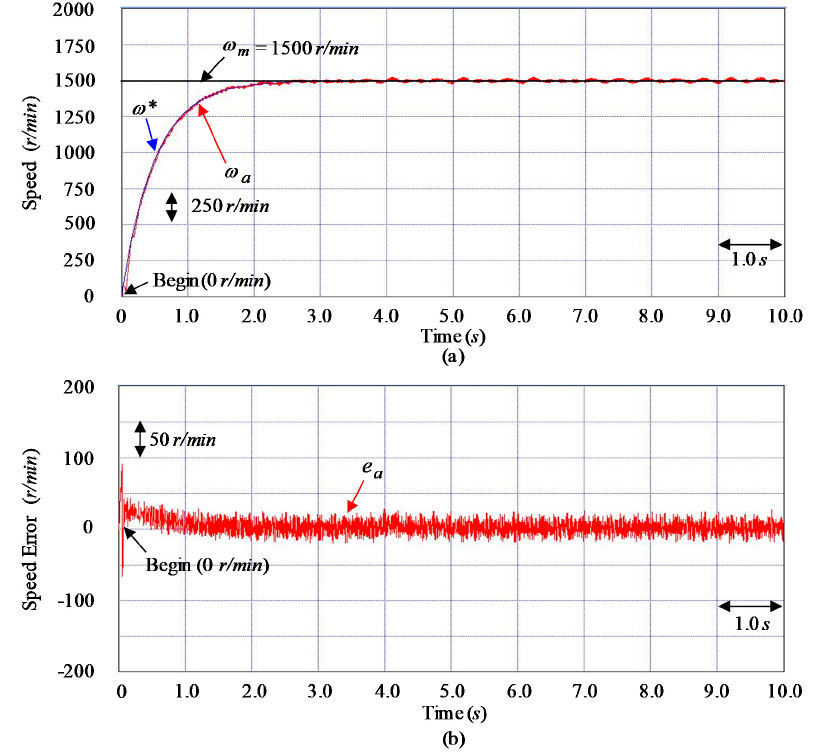
Figure 6. Tested results for the SIM expelling CVT organized system at the tested Event E1 case by using the controller CT1: ( a ) speed response, ( b ) speed discrepancy response. Mathematics 2020 , 8 , x FOR PEER REVIEW